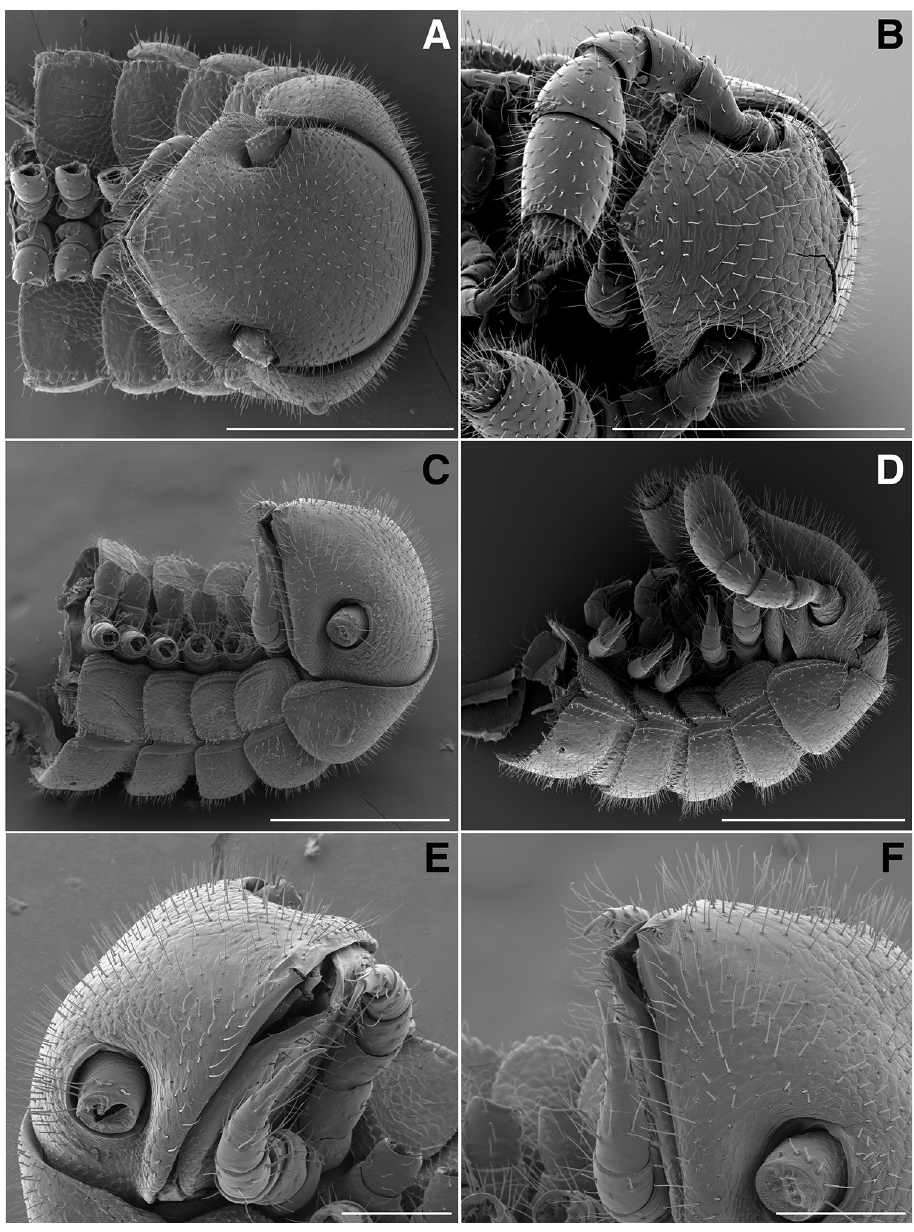
Figure 2. A Dorsal view of head, antennae and rings 1–5 of I. tobini sp. n. (scale bar 300 µm) B the same of I. plenipes (scale bar 300 µm) C Lateral (right) view of head and rings 1–5 of I. tobini sp. n. (scale bar 300 µm) D the same of I. plenipes (scale bar 300 µm). Illacme tobini sp. n.: E anterolateral (right) view of head and first leg pair (scale bar 100 µm) F lateral (left) view of head and first leg pair, antennae broken off at base (scale bar 100 µm). (Catalog #s: I. tobini sp. n. MPE00735, I. plenipes